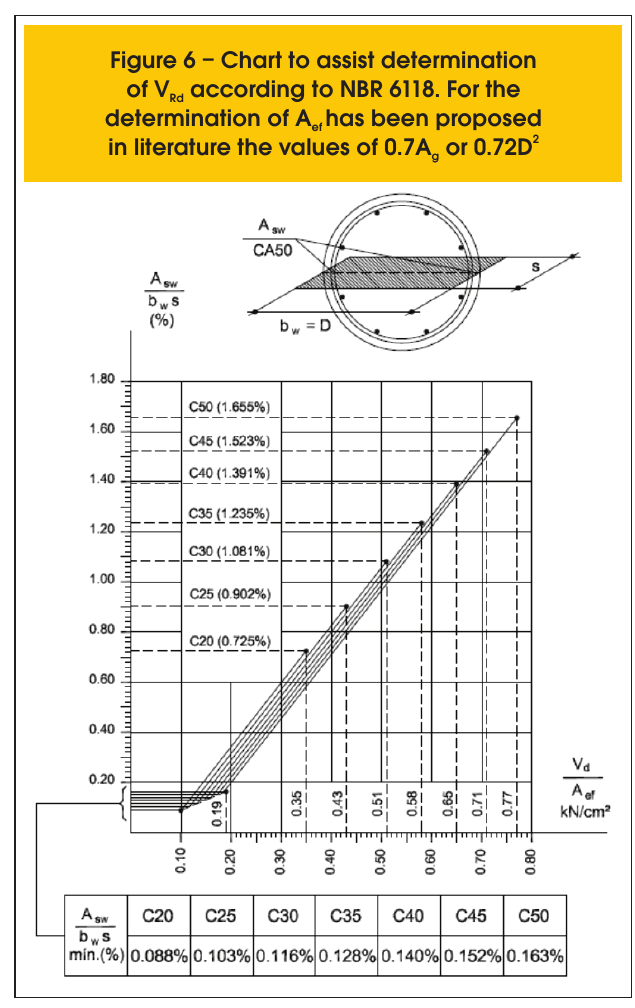
Figure 5 – Definition of effective area of circular cross section of reinforced concrete with reinforcement distributed